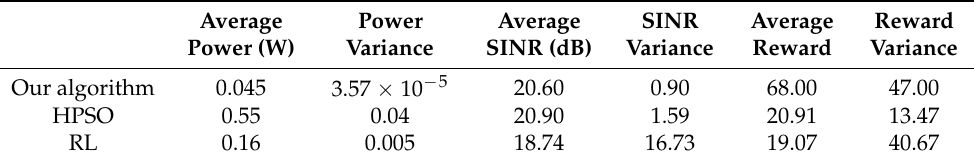
Figure 6. Network performance with different numbers of links. Table 2. Comparison of network performances under different random